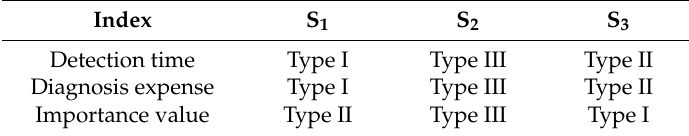
Table 1. The selection result of the whitening weight functions.